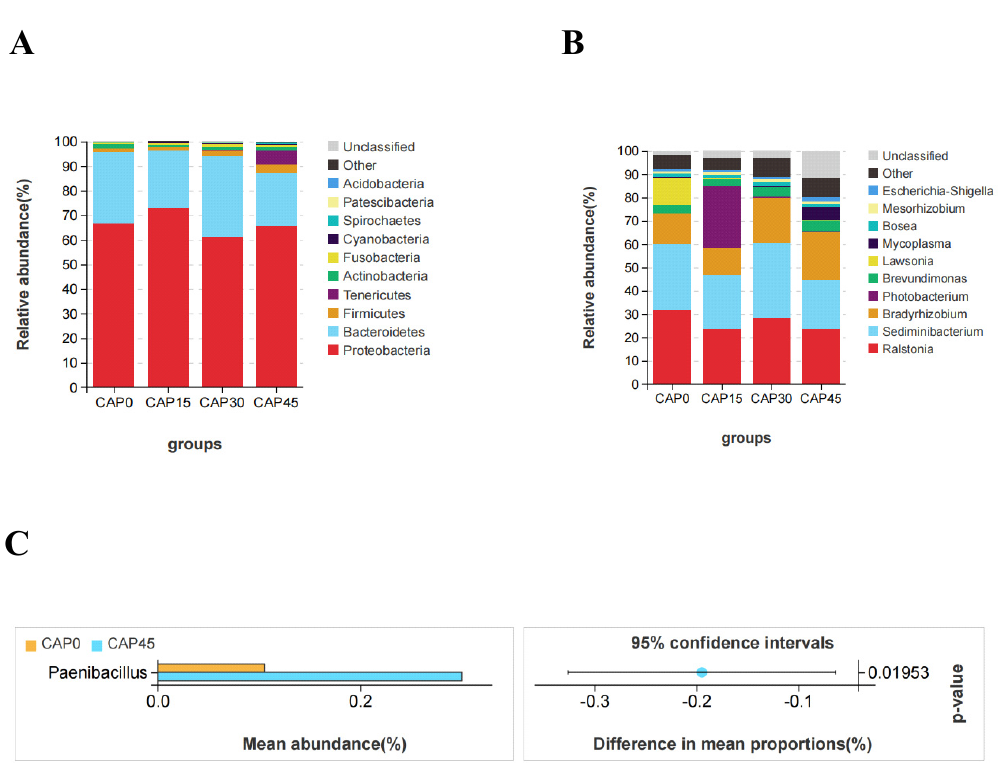
Figure 4. Barplot ( A ) and barplot ( B ) were used to represent the relative abundance of the major intestinal bacterial phyla and genera, respectively. ( C ) Difference in Paenibacillus was calculated by Welch’s t -test ( p < 0.05).